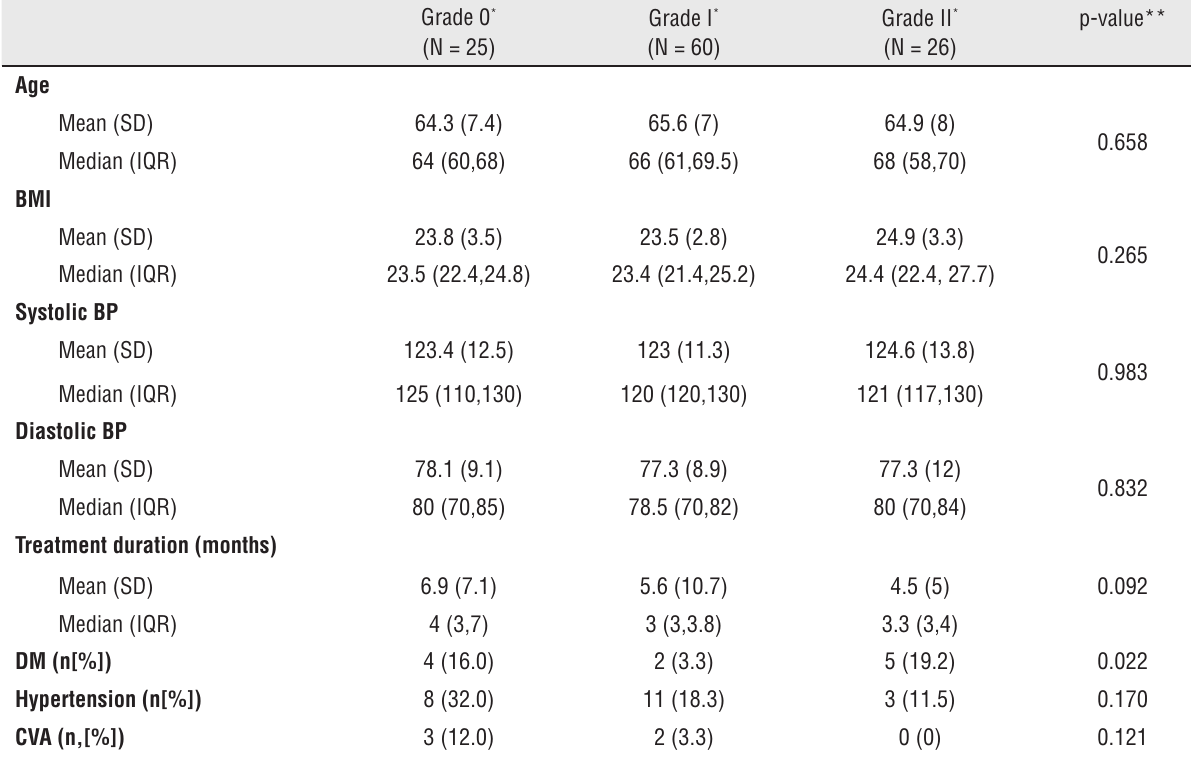
Table 1 - Demographic data of study participants (mean [SD], median